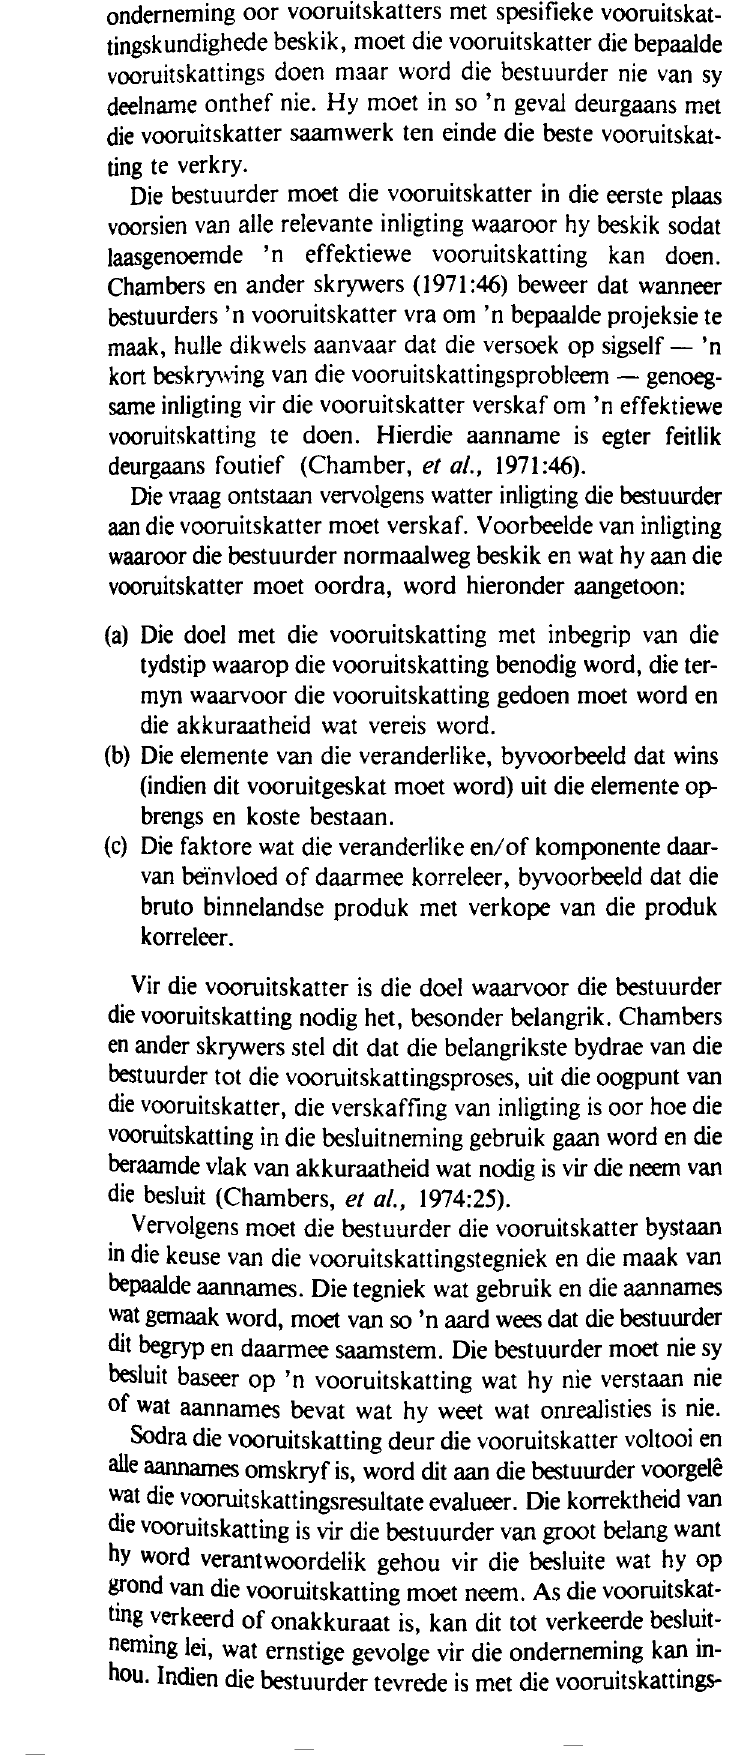
Seisoenskommelings